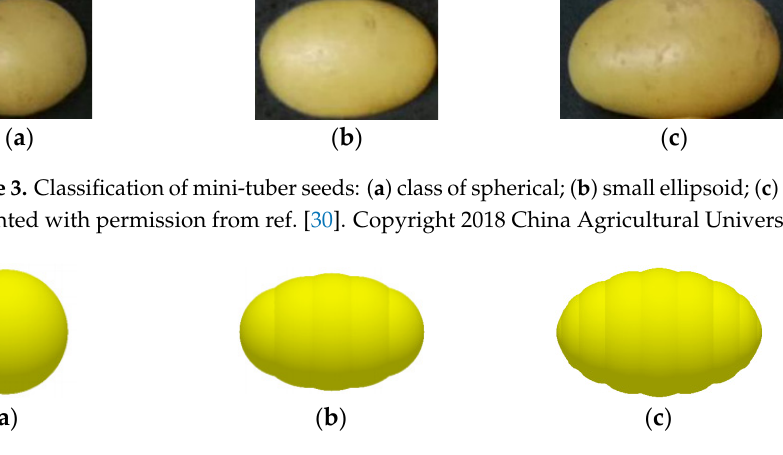
Figure 4. Discrete element model of mini-tuber seed: ( a ) class of spherical; ( b ) small ellipsoid; ( c ) large ellipsoid. Reprinted with permission from ref. [30]. Copyright 2018 China Agricultural University.